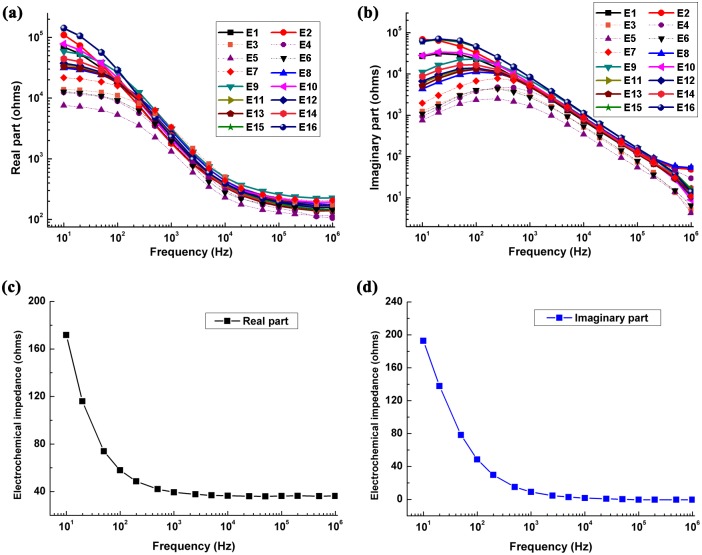
(a)(b) The contact impedance of all subjects at all electrodes. The dashed lines represent the measurement results of the electrodes at the forehead. (c)(d) The measurement results of electrochemical impedance and conductive gel impedance in the case of conductive gel with the thickness of 0.4 mm.